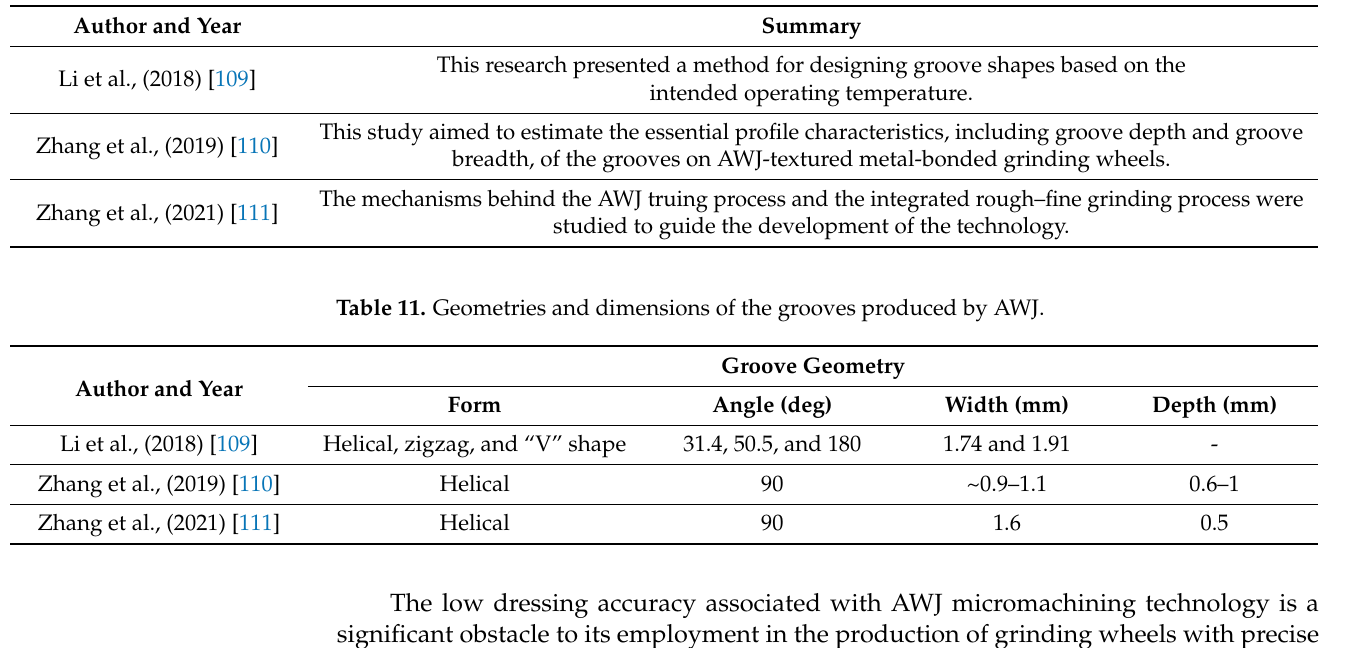
Figure 19. Illustration of the texturing procedure by microabrasive waterjet [108]. Table 10. Summary of publications on grooves produced by AWJ.